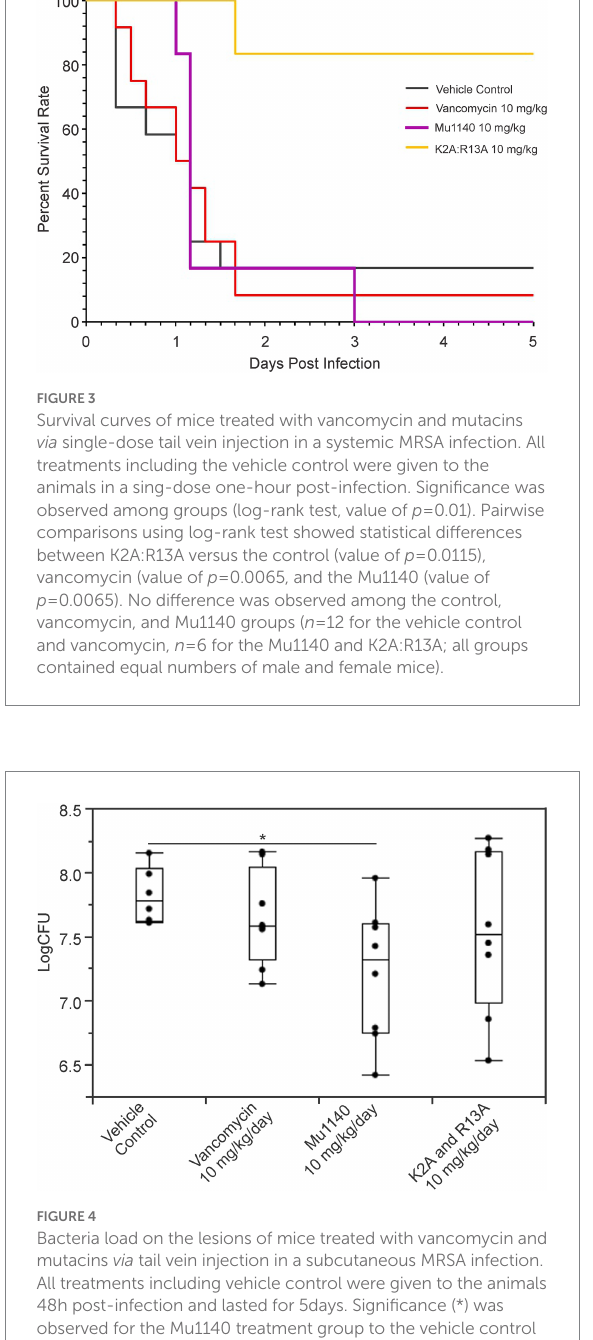
Cohen’s d = 1.11, value of p = 0.0754). The 10 mg/kg/day combined K2A:R13A analog group and the 10 mg/kg/day fusidic acid treatment group had 2.25 and 2.17 log reductions in bacterial load compared to the vehicle control group (Student’s t -test, Cohen’s d = 0.89 and 0.86, value of p = 0.15 and 0.16). The